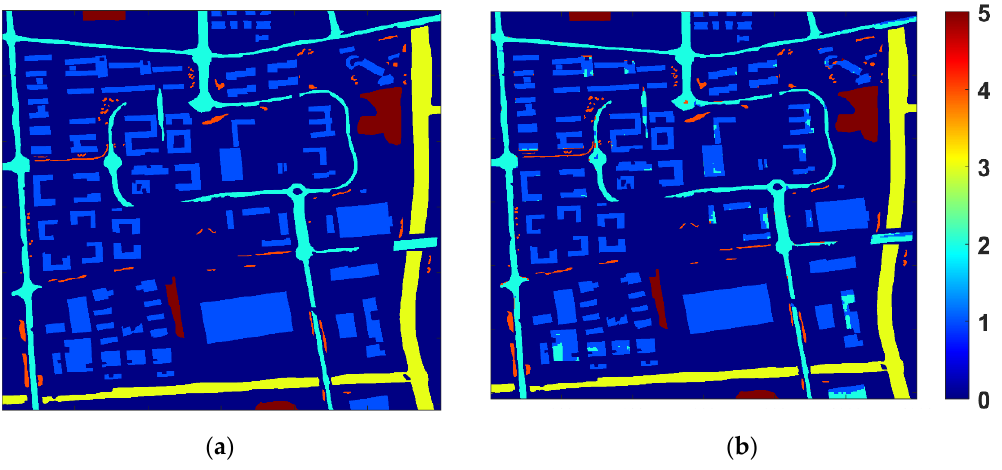
Figure 1. SH data set. ( a ) Classification map. ( b ) Reference map.